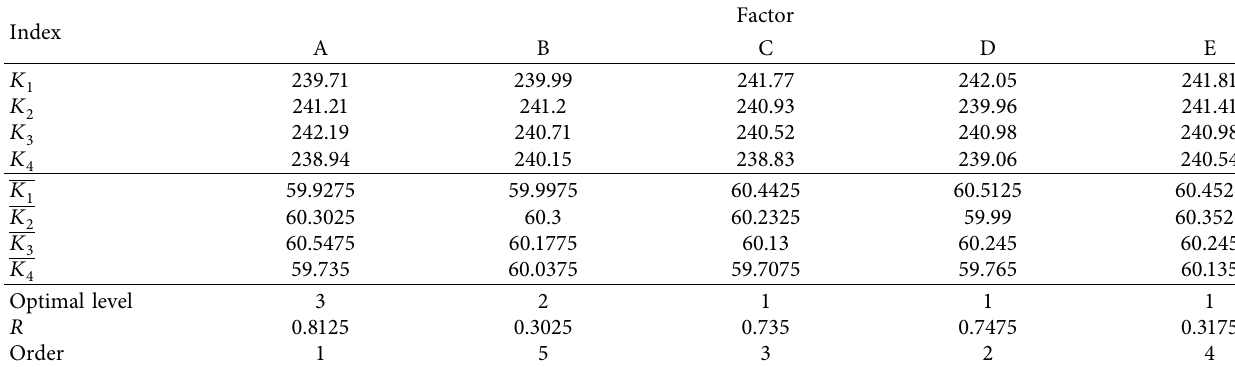
Table 7: Extreme diference analysis of